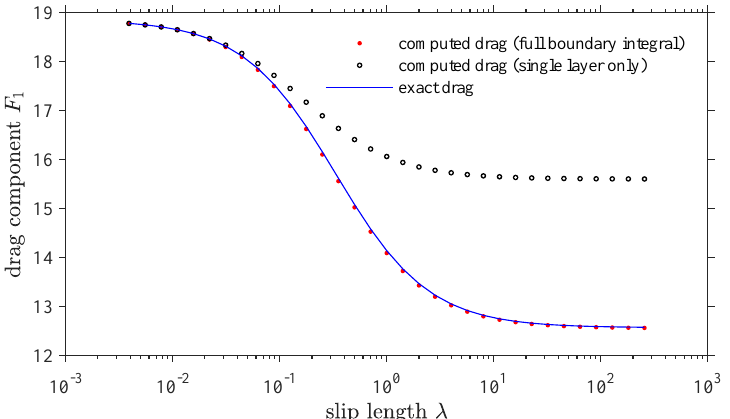
Figure 3. Solution to resistance problem [P] as a function of slip length λ , comparing computed results with the full boundary integral Equation (40), single-layer-only equation, and exact solution (regularisation parameter (cid:101) = 0.01, discretisation parameters 7200 DoF, and h q = 0.0333.